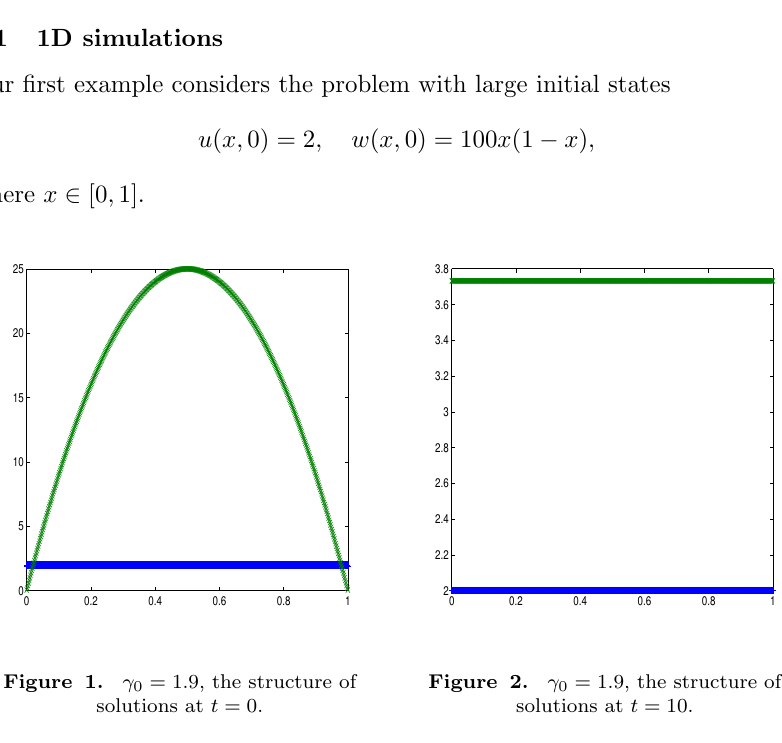
Figure 1. γ 0 = 1 . 9, the structure of solutions at t = 0.